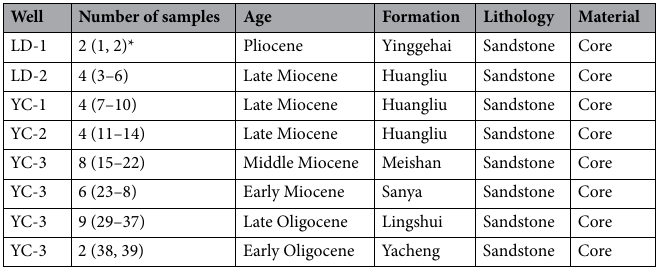
Table 1. Stratigraphic positions of the samples analyzed in this study. *Total (Sample